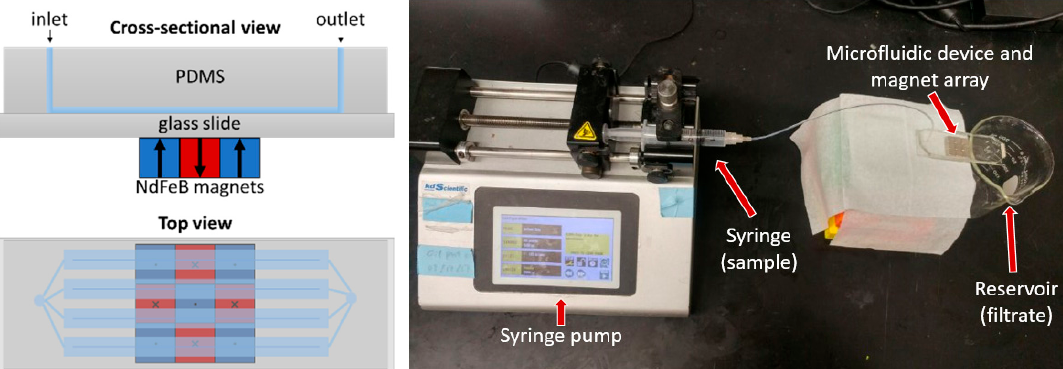
Figure 3. Magnetic separation microfluidic device diagram and experimental setup image (microfluidic Figure 3: Magnetic separation microfluidic device diagram and experimental setup image device with magnets and syringe (microfluidic device with magnets and syringe pump).